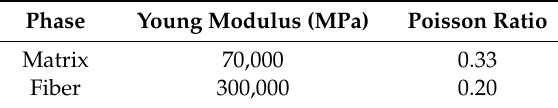
Figure 3. Representative volume elements representing composites reinforced with following volume fractions of cylindrical fibers: ( a ) 0.05; ( b ) 0.10; ( c ) 0.15. Table 1. Elastic properties of matrix and fiber.